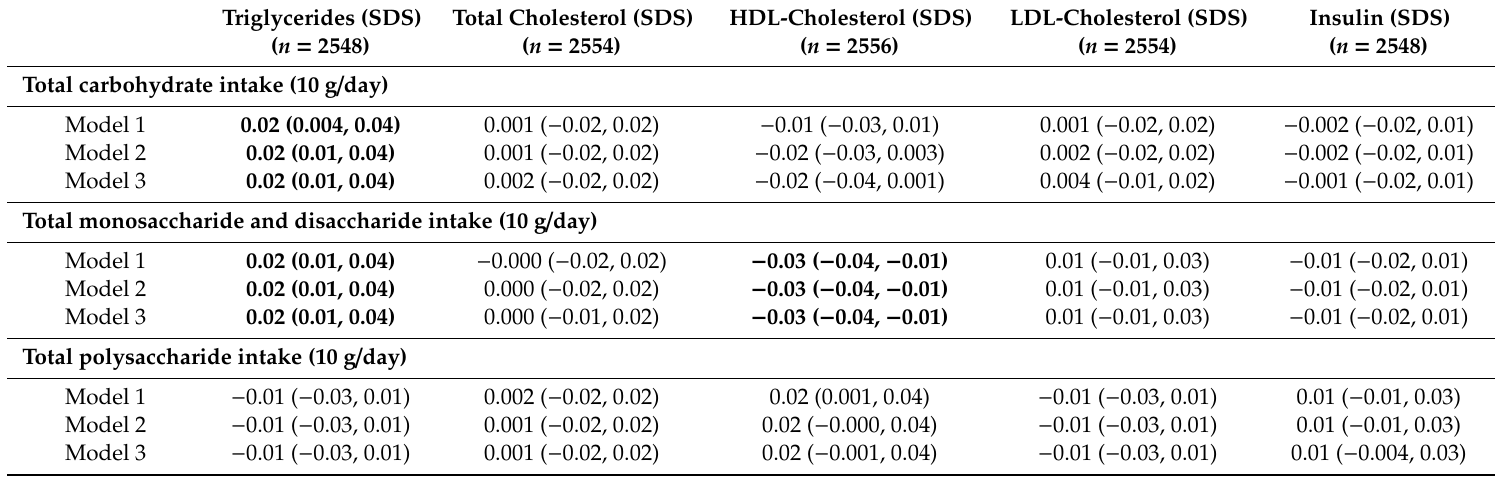
Table 3. Associations of carbohydrate intake at age 1 year with metabolic health up to age 10